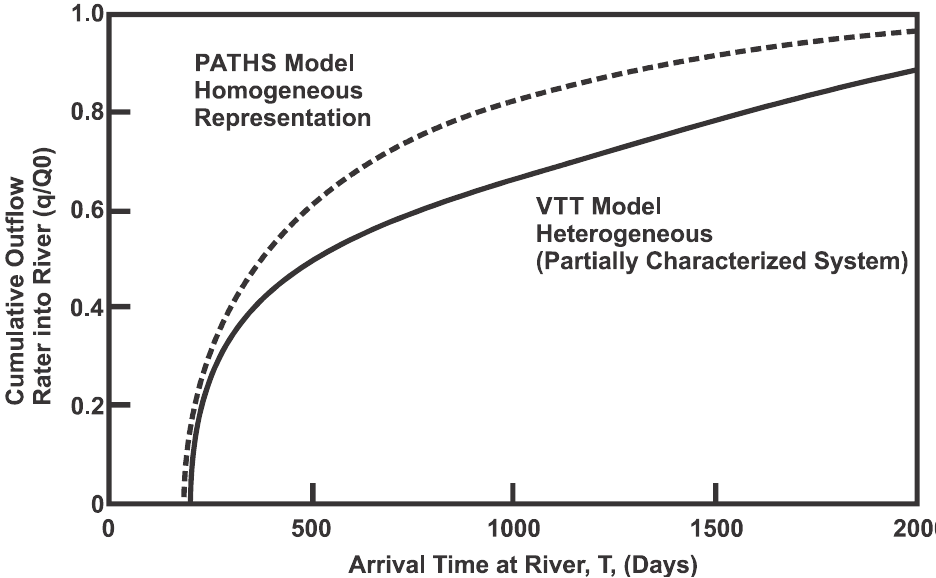
Figure 3. Arrival time distributions at the river for the heterogeneous flow systems and the homogenous bounding system computed using minimum energy principles. bounding system computed using minimum energy